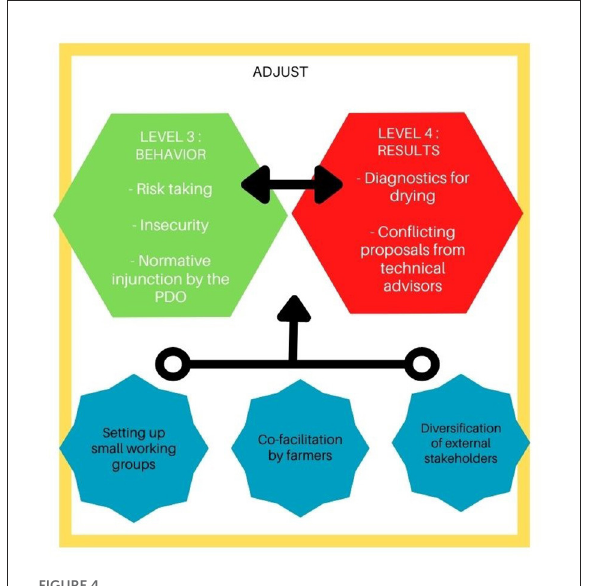
FIGURE4 Adjustments of behavioral changes (level 3) and practical actions (level 4), based on New World Kirkpatrick Model